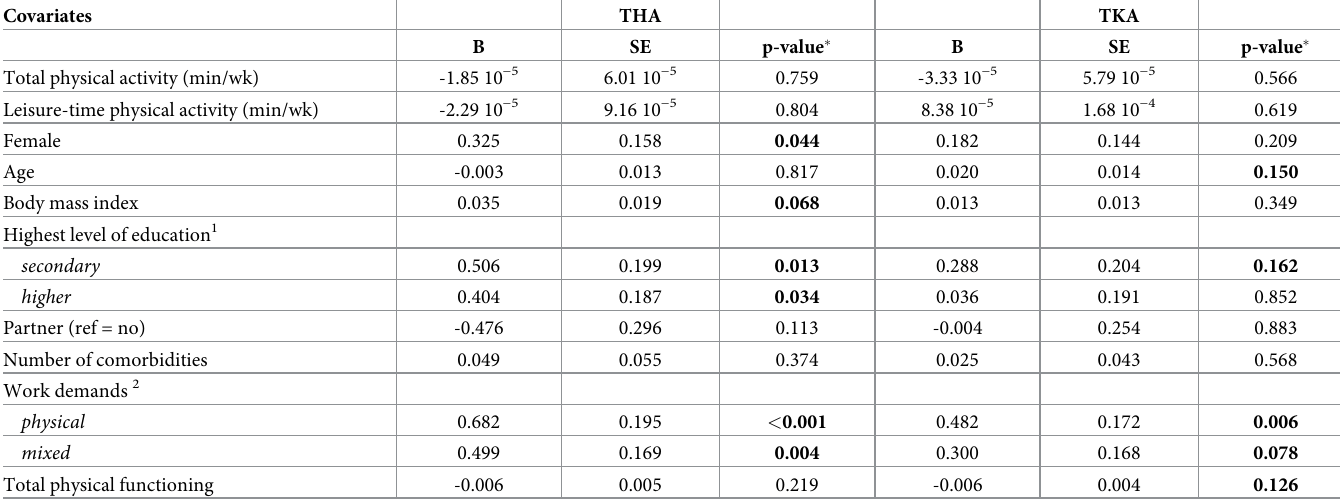
Table 2. Results of the simple regression analyses for physical activity and RTW, for THA and TKA patients separately. Covariates